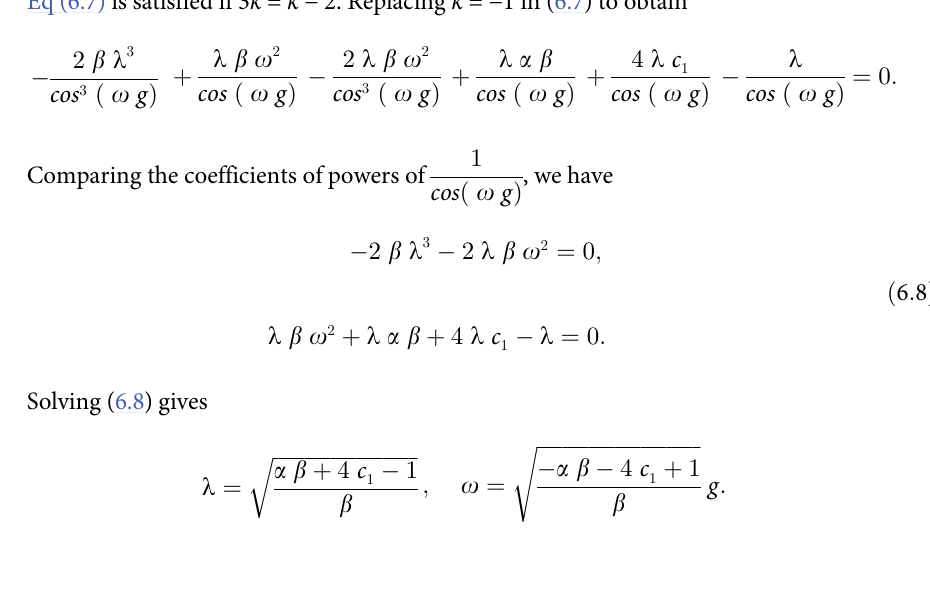
ffiffiffiffiffiffiffiffiffiffiffiffiffiffiffiffiffiffiffiffiffiffiffiffiffiffiffiffi a b þ 4 c (cid:0) 1 1